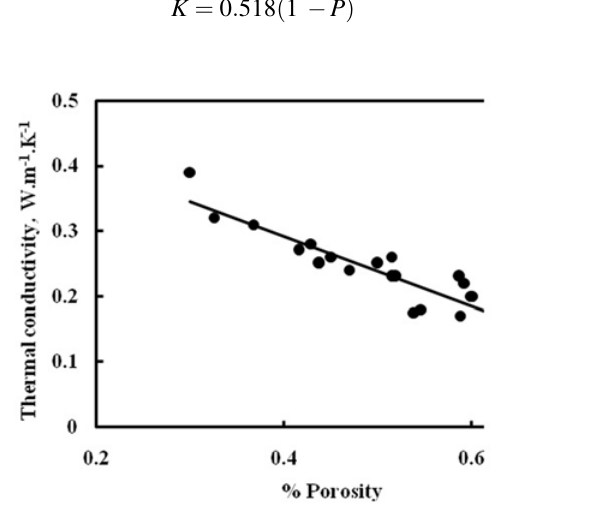
Figure 13. Relation between thermal conductivity (at 400 o C) and porosity of Bagasse based bricks